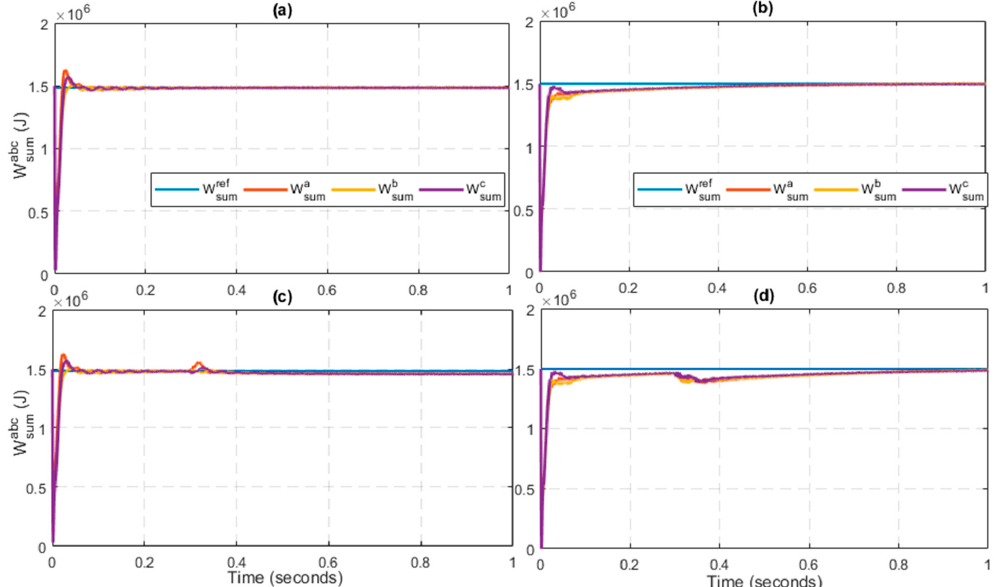
Figure 7. Energy sum ( a ) Proposed controller with constant reference; ( b ) PR controller with constant reference; ( c ) Proposed controller with stepped reference; ( d ) PR controller with stepped reference.